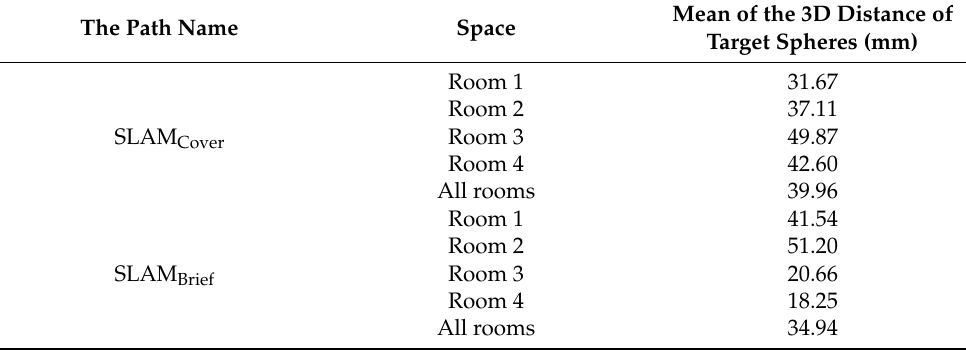
Table 6. The results for the 3D distance between target spheres in TLS room and reference (TLS reference_room ). The path name tells that the TLS room point cloud is registered either with the point cloud of SLAM Cover or SLAM Brief